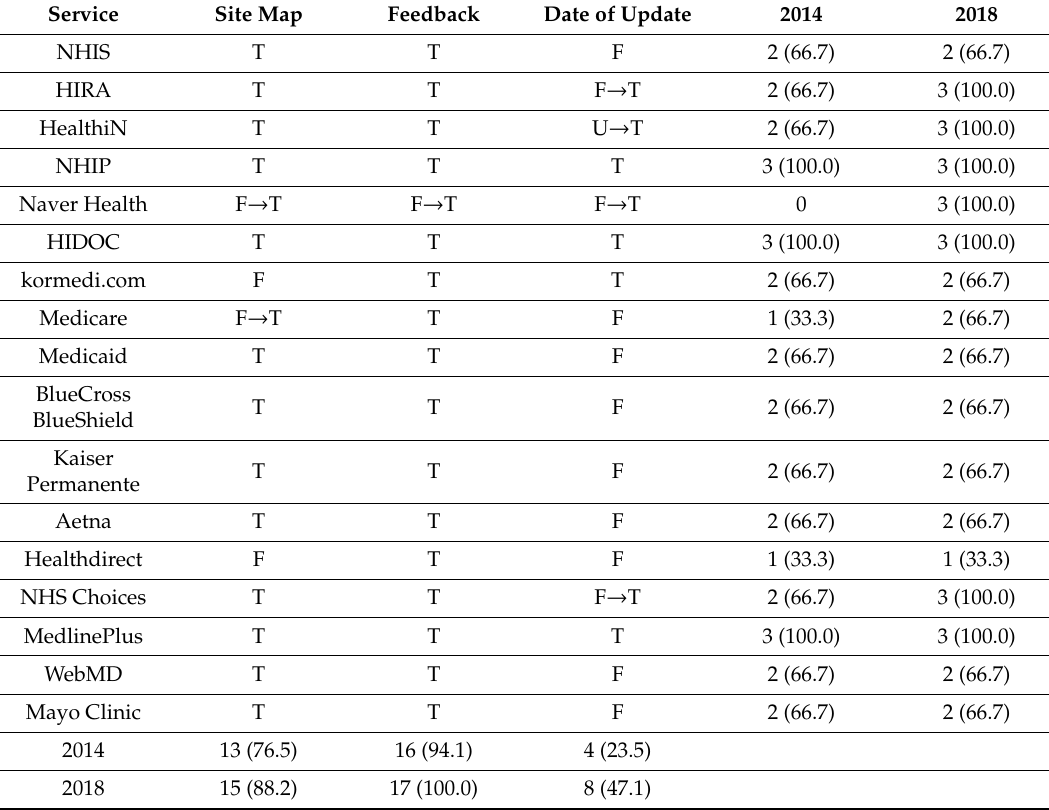
Table 3. Changed external portal structure of health information portals. (Frequency, %).